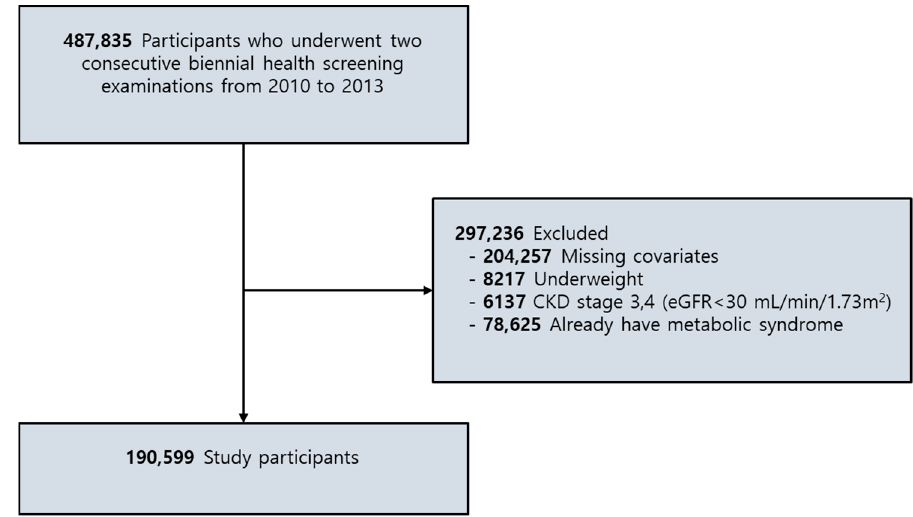
Figure 1. Flow diagram showing the selection of study participants. CKD, chronic kidney disease. eGFR estimated glomerular filtration rate.